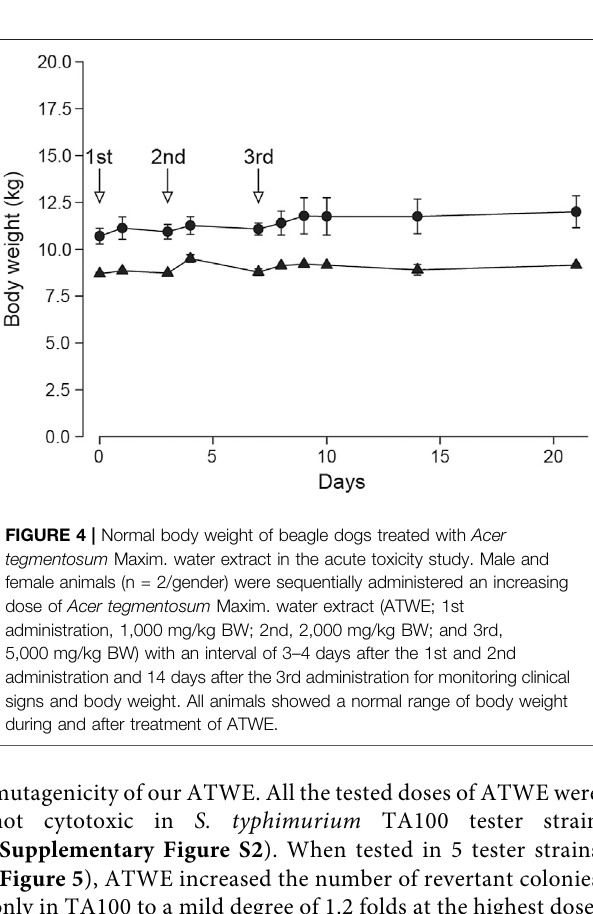
( Supplementary Figure S2 ). When tested in 5 tester strains ( Figure 5 ), ATWE increased the number of revertant colonies only in TA100 to a mild degree of 1.2 folds at the highest dose.